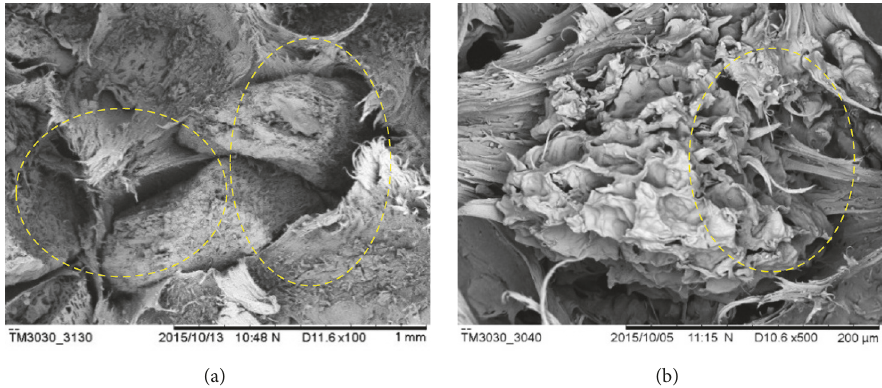
Figure 5: SEM image of breaking surface of composites types (a) B2 and (b) C2. The yellow circles in (a) are to show the gaps in between GCW/oxo-HDPE composites, poor adhesion and in (b) to show better adhesion between GCW/oxo-HDPE after treatment, better adhesion.